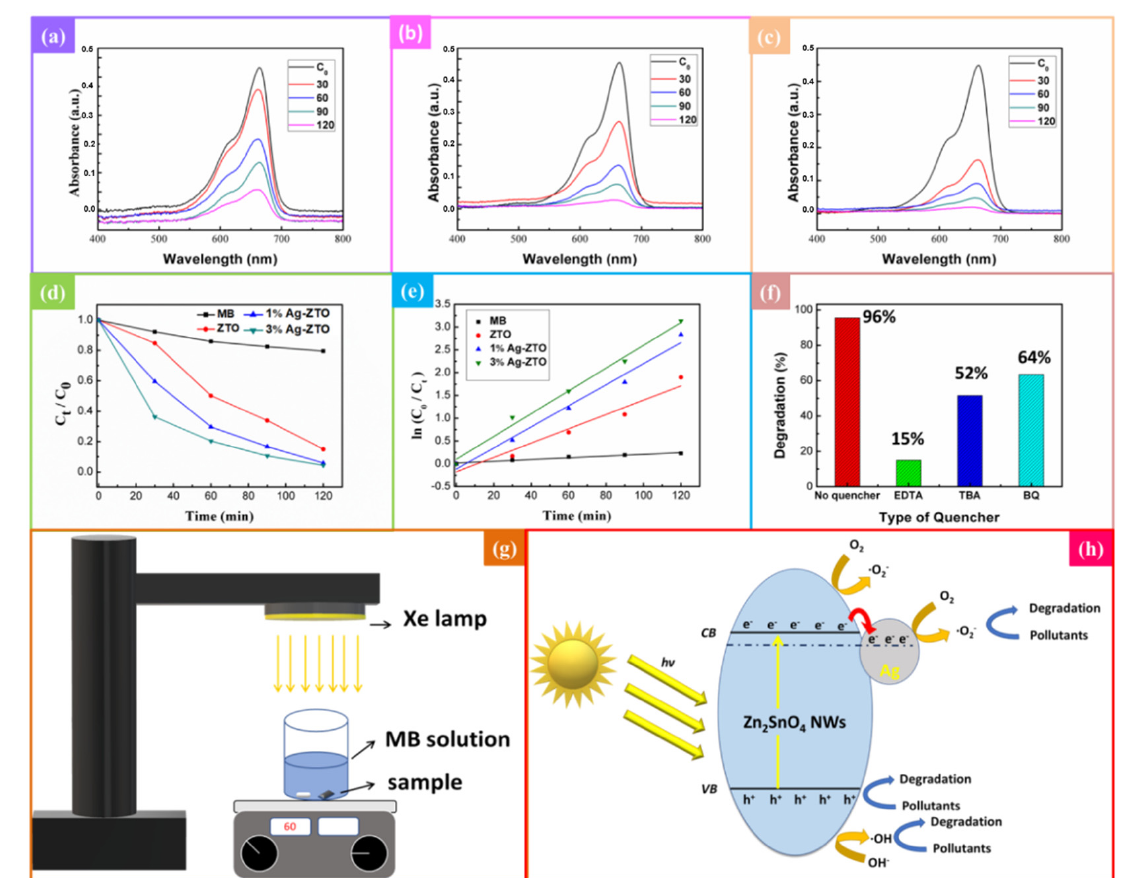
Figure 5. Photocatalytic properties of ZTO NWs and Ag-ZTO NWs were evaluated with 10 ppm methylene blue in deionized water (pH = 7, I = 0.001 M). The UV–Vis absorbance spectra of ( a ) ZTO NWs, ( b ) 1 at% Ag-ZTO NWs, ( c ) 3 at% Ag-ZTO NWs towards MB dye. ( d , e ) Comparison of photocatalytic activities between ZTO NWs and Ag-ZTO NWs. ( f ) Comparison of photocatalytic activities among different scavengers for 3 at% Ag-ZTO NWs. ( g ) Schematic illustration of photodegradation experimental setup. ( h ) Schematic illustration for photodegradation mechanism of Ag-ZTO NWs.